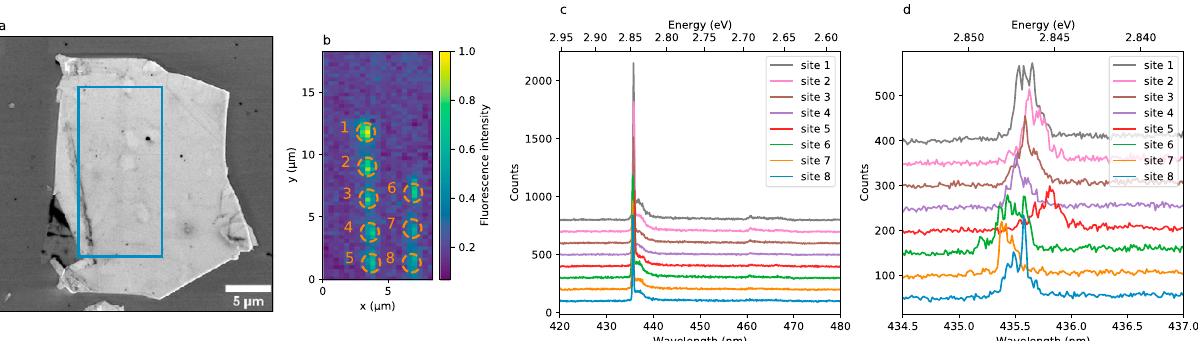
Fig. 1 Activation of localized ensembles of SPEs on a hBN fl ake. a SEM image of a high-purity hBN fl ake of about 15 × 20 μ m and 60 nm thickness. b Confocal map of the irradiated zone (blue rectangle in a ) with eight irradiation spots (orange dashed lines). ( c ) and ( d ) Low-temperature spectra of the eight spots with two different spectral resolutions, showing a reproducible ZPL within 0.7 nm.